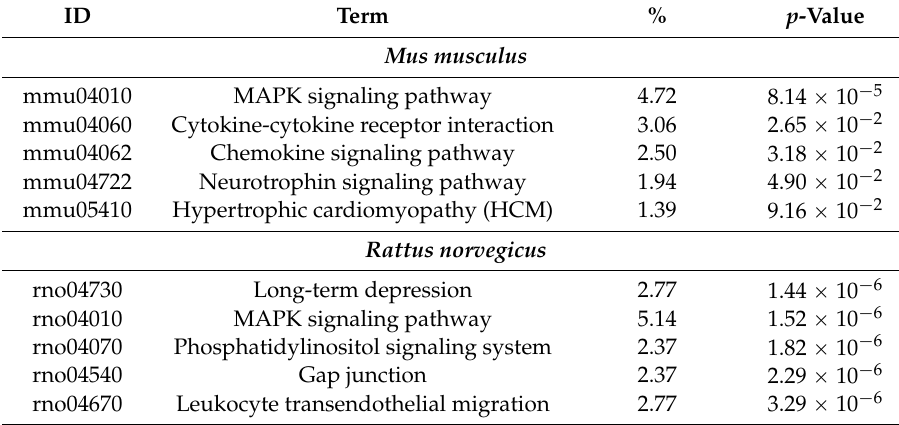
Table 3. List of the top five pathways based on Kyoto Encyclopedia of Genes and Genomes (KEGG) analysis.